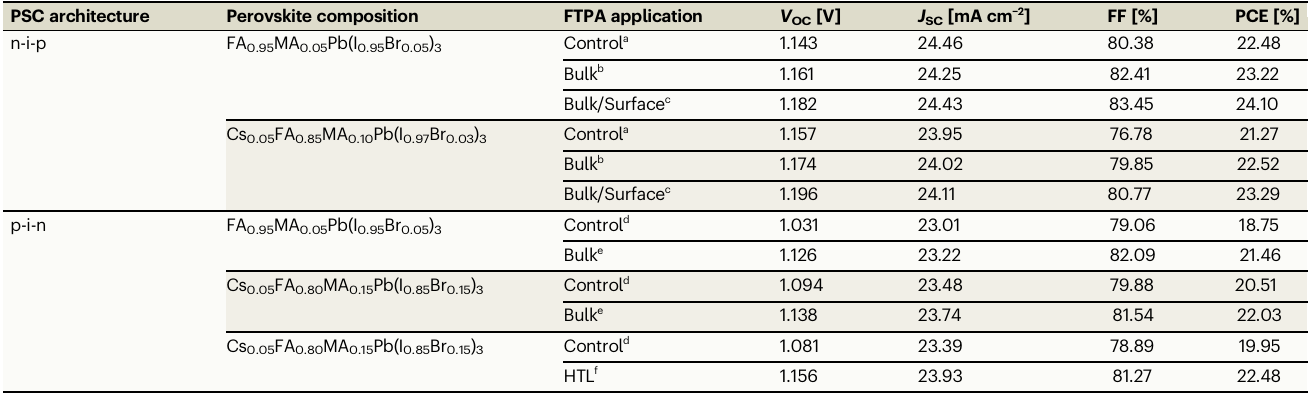
a FTO/CBD-SnO 2 /perovskite/Spiro-OMeTAD/Au; b FTO/CBD-SnO 2 /perovskite-FTPA/Spiro-OMeTAD/Au; c FTO/CBD-SnO 2 /perovskite-FTPA/FTPA/Spiro-OMeTAD/Au; d ITO/PTAA/perovskite/PC 61 BM/C 60 /BCP/Ag;